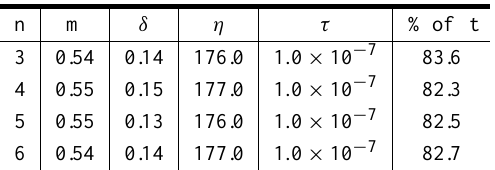
Dias’ parameters for the given electrode spreads n, employing the disk electrode(R= 0.025 m) at the sea